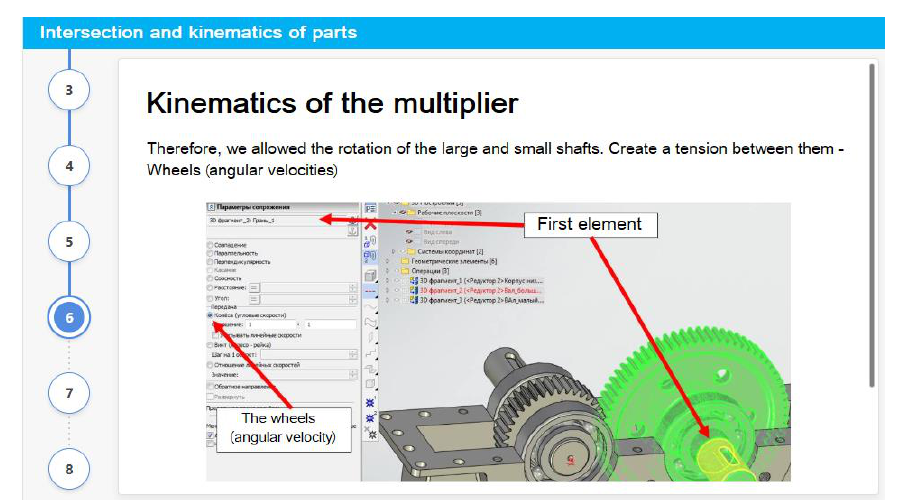
Fig. 15 . Implementation of kinematic links in the multiplier.